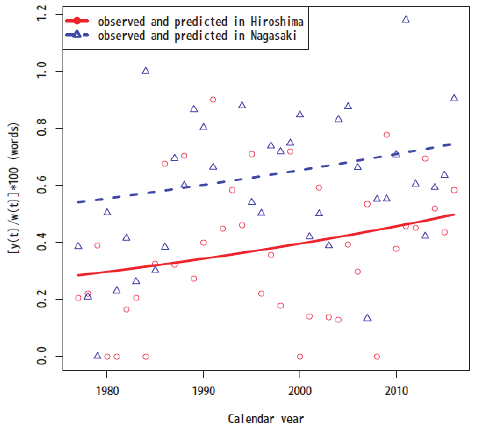
Fig. 3. Observed and predicted frequencies of "people"